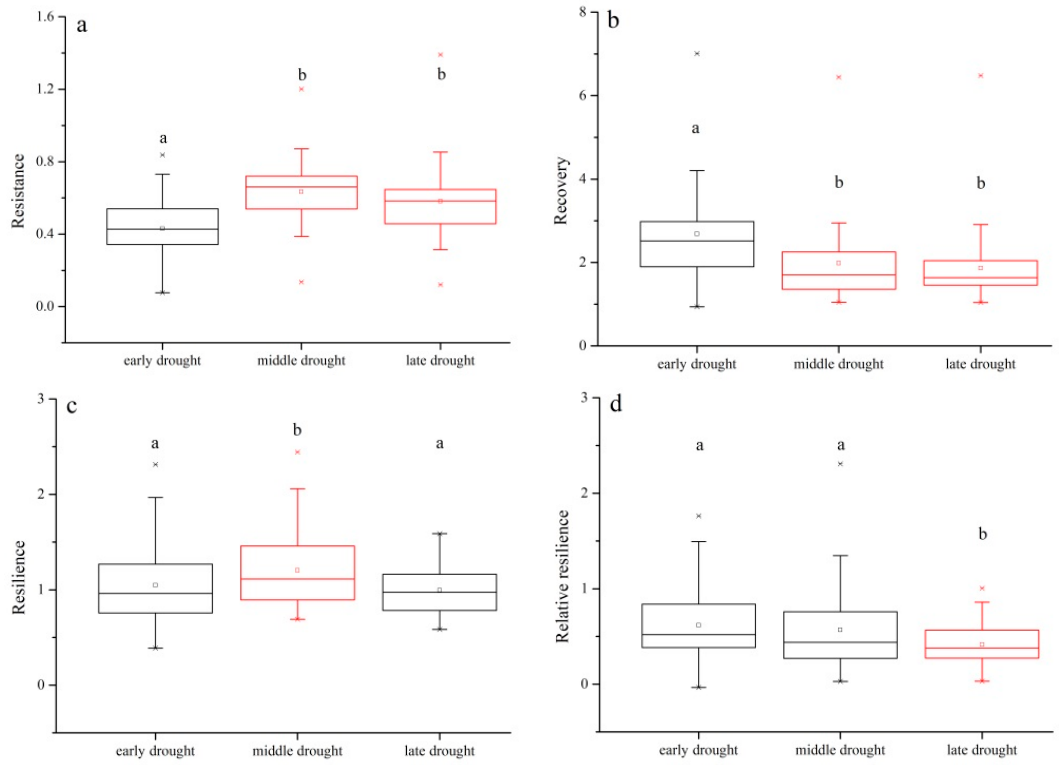
Figure 9. The di ff erences in stable indices (( a ): Resistance; ( b ): Recovery; ( c ): Resilience, ( d ): Relative resilience) at SDL3 and SDL4 for the early drought event, middle drought event, and late drought event indicated by ANOVA analysis. The di ff erent letters above the boxes indicate significant di ff erences between the two boxes, the same letter indicates insignificant di ff erence. The time period of the early drought is 1971, middle drought is 1995, late drought is 2001.